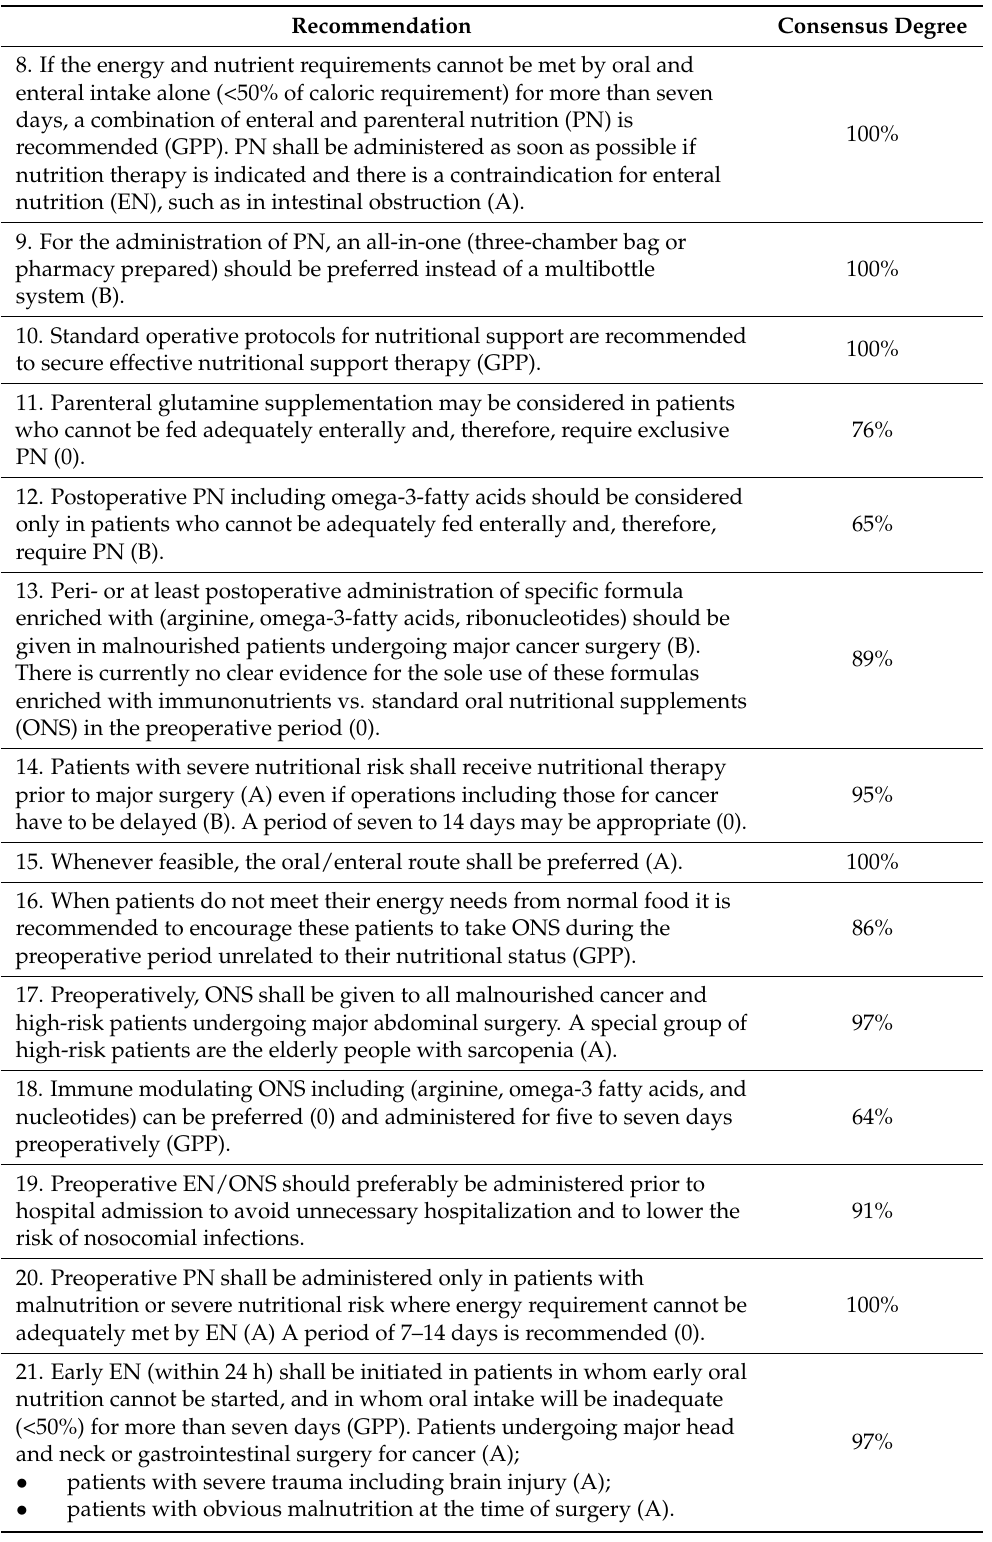
Table 1. Cont. Recommendation Consensus